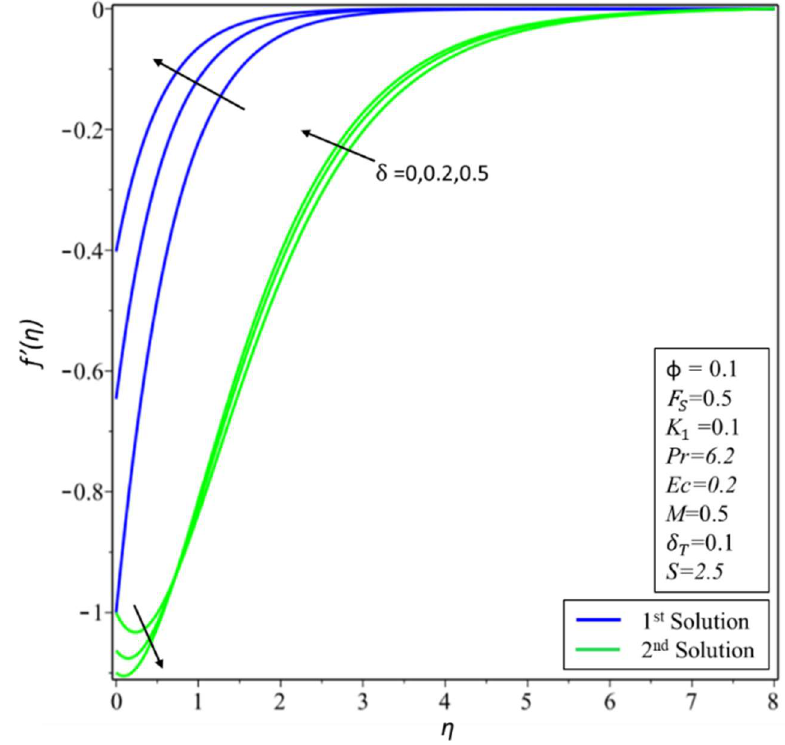
Figure 8. Changes of 𝑓′(𝜂) for 𝛿 .